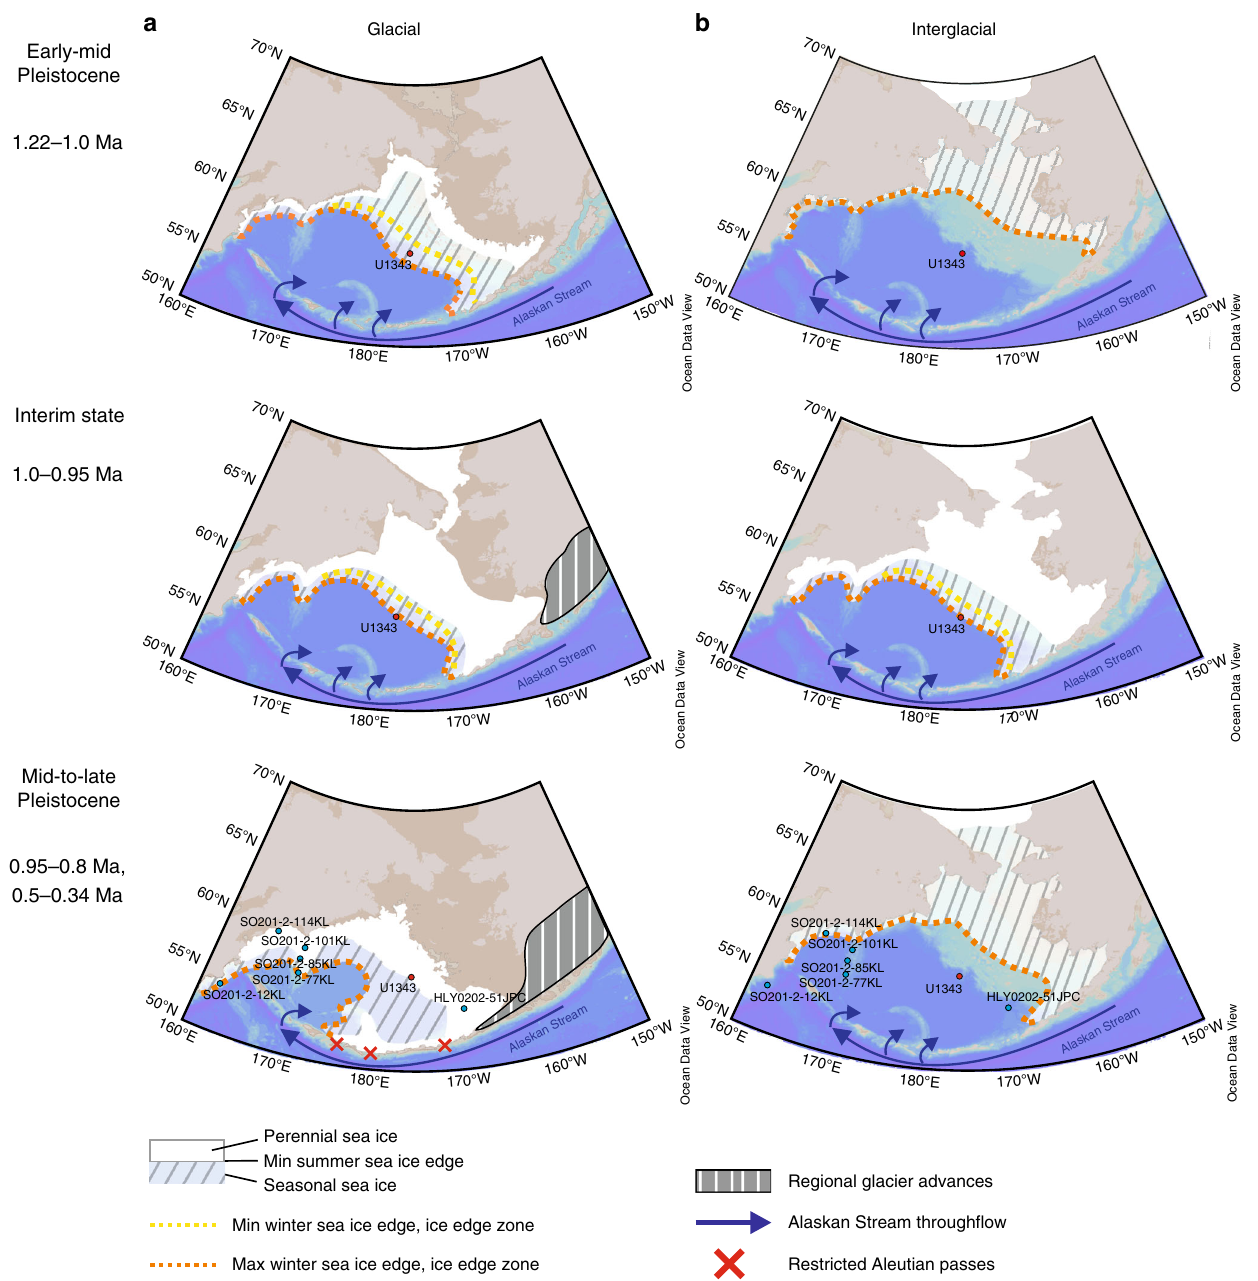
Fig. 5 Schematic overview of the twofold change in sea ice dynamics across the Mid-Pleistocene in the Bering Sea. Simpli fi ed schematic of sea ice changes in the Bering Sea across the Mid-Pleistocene showing the sea ice dynamics across the three intervals identi fi ed as the early-mid Pleistocene (1.22 − 1.0 Ma), an interim state (1.0 − 0.95 Ma), and the mid-to-late Pleistocene (0.95 − 0.8 Ma and 0.5 – 0.3 Ma). a Sea ice dynamics across glacial intervals of the respective time period. b Sea ice dynamics across interglacial intervals of the respective time period. Maps were created using Ocean Data View 69 . Glacial sea level is based on δ 18 O seawater from DSDP Site 607 48 and ODP Site 1123 50 with the coastline representing the average minimum sea level across all glacial intervals of that period. The mid-to-late Pleistocene glacial sea ice schematic is additionally supported by studies from the Umnak Plateau 44 and the western Bering Sea 21, 67 across Termination I (blue dots). Continental glacier advances are simpli fi ed schematics based on maximum Pleistocene